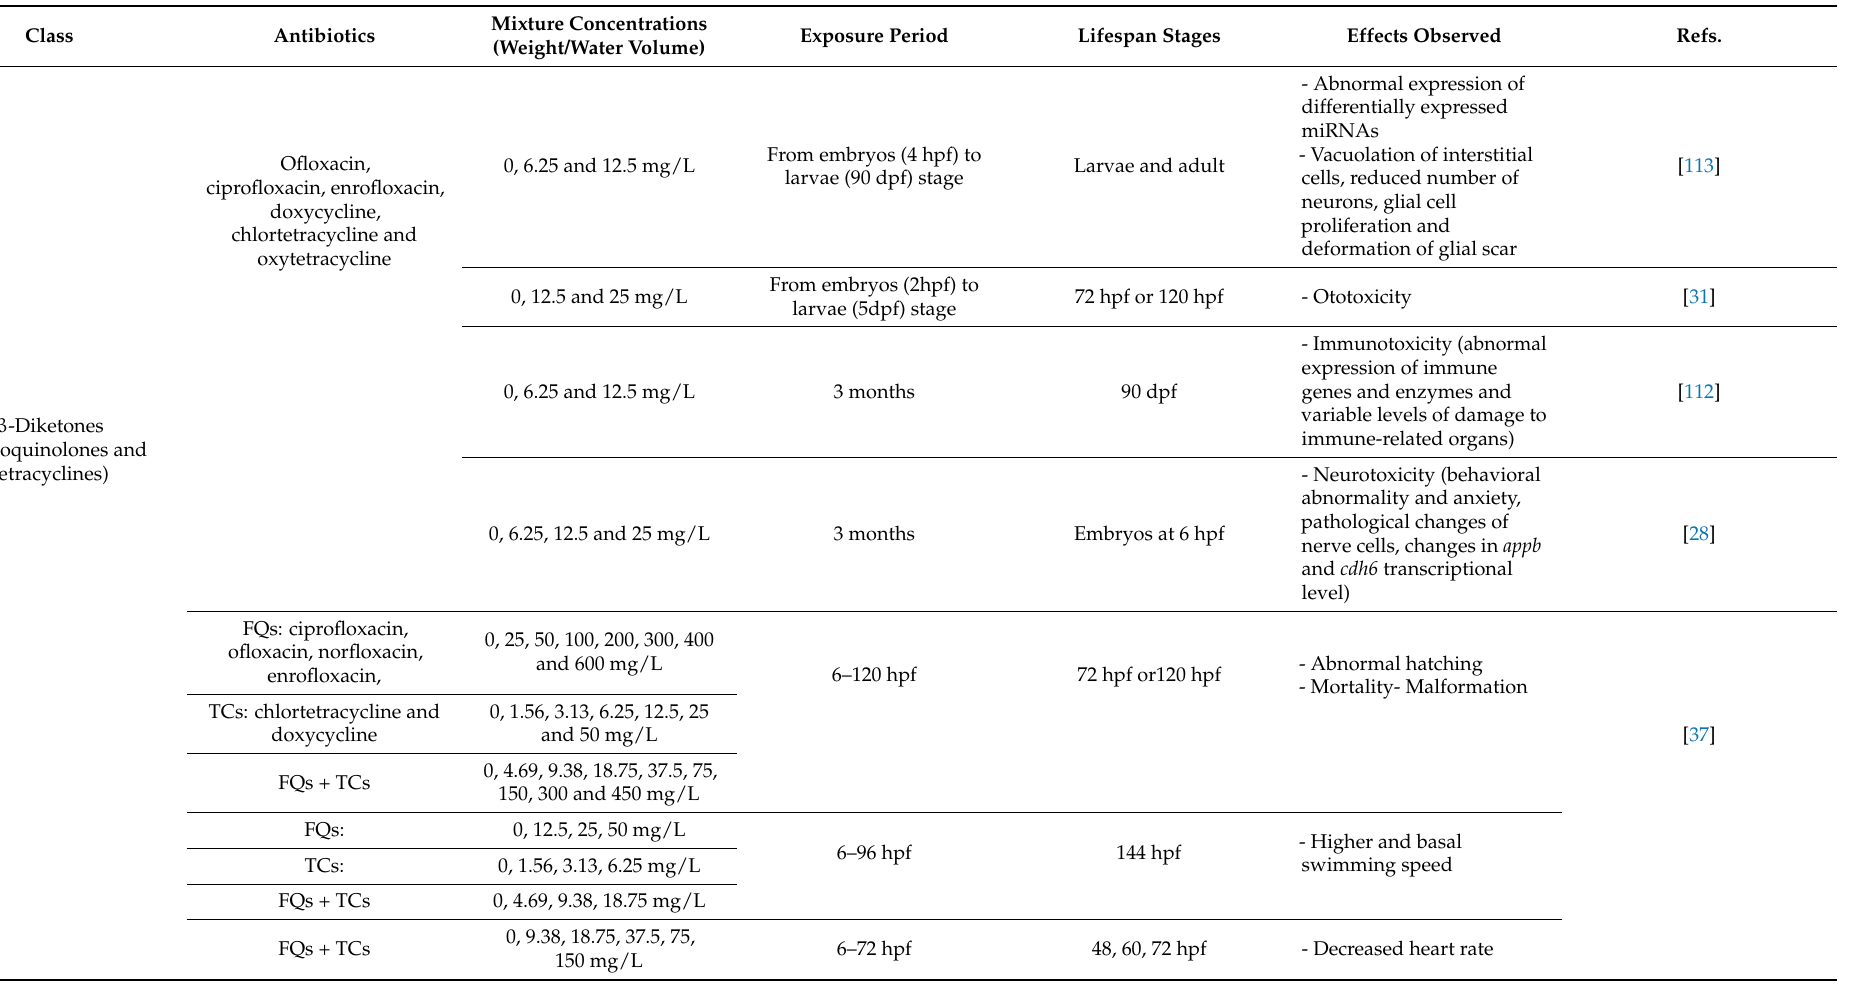
Table 4. Overview of the potential biological effects of antibiotics represented as mixtures in zebrafish, dating from 2014 to the